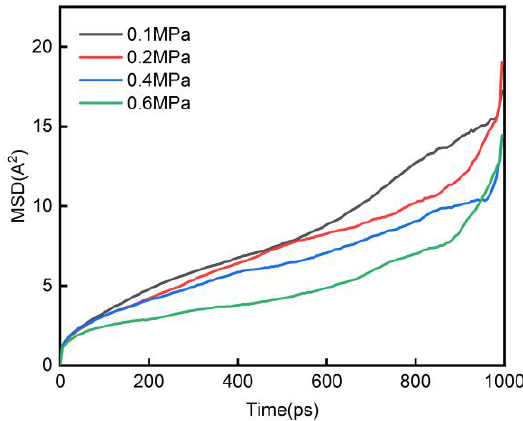
Figure 6. MSD curves of the cellulose chain under different pressures .